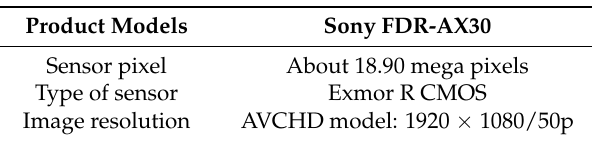
Table 3. Key technical parameter of camera.